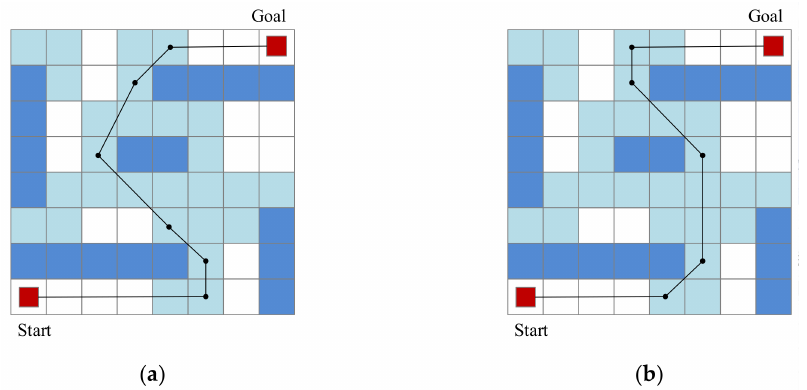
Figure 16. Parents of the crossover operation ( a ) Parent 1; ( b ) Parent 2.